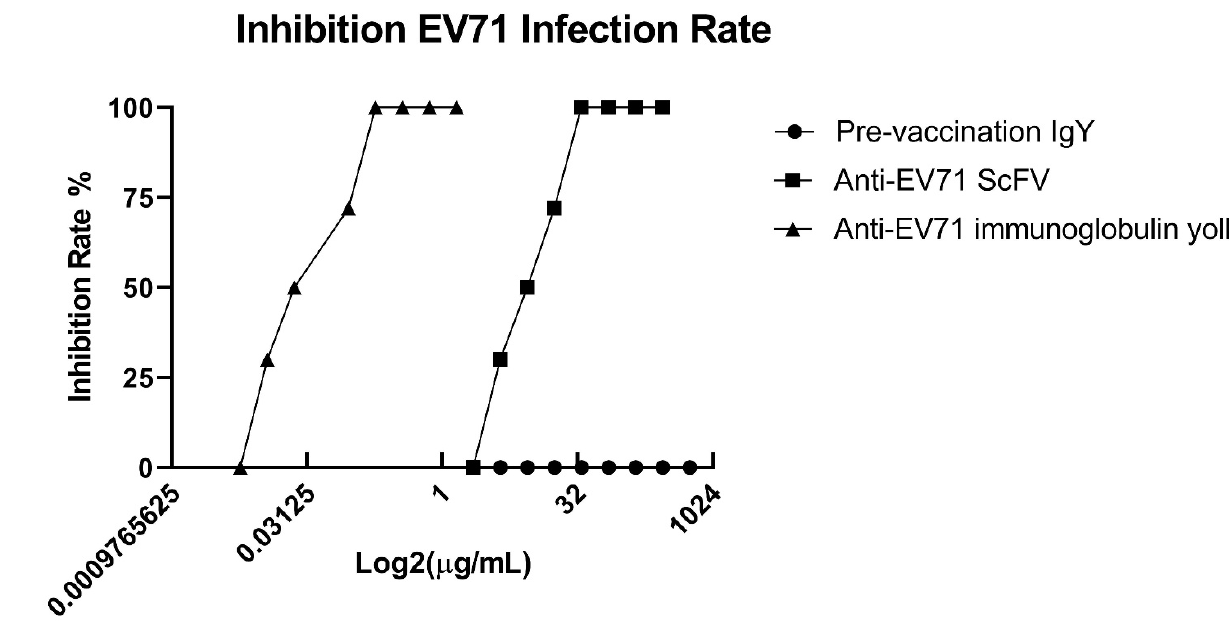
Figure 6. Analysis of IgY and scFv antibodies neutralizing activity. The EV71-infected RD cells were incubated with various concentrations of antibodies. After incubation, the density of the well at 570 nm was measured and the 50% inhibitory concentrations (IC 50 ) were calculated according to the formula described in the material and method. All experiments were carried out in a triplicated manner.